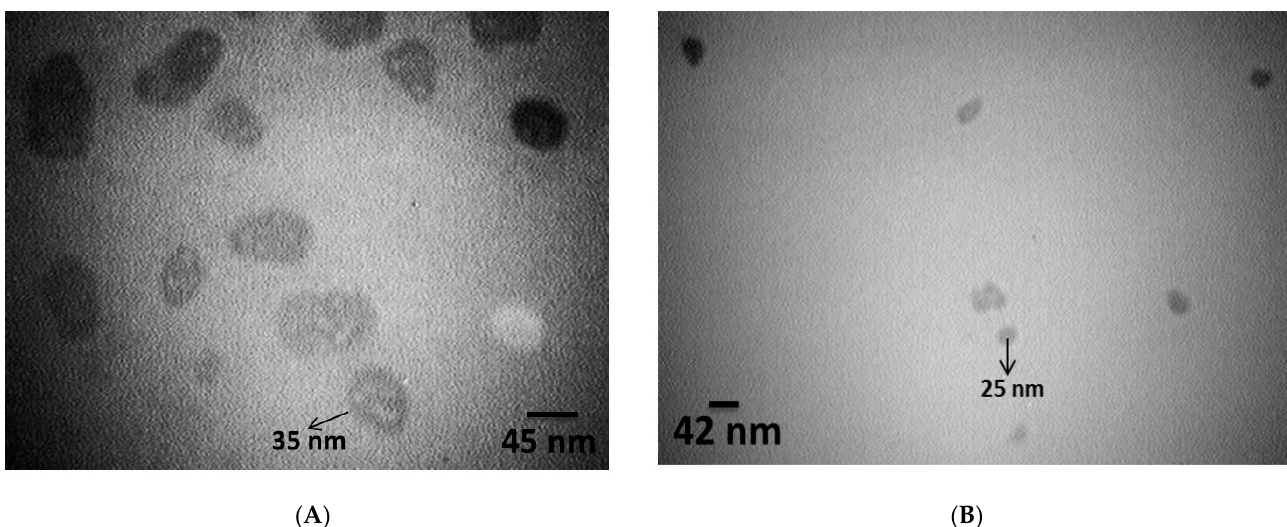
Figure 1. TEM images of AL–acetamiprid ( A ) and PEG–acetamiprid ( B ) nanoparticles.